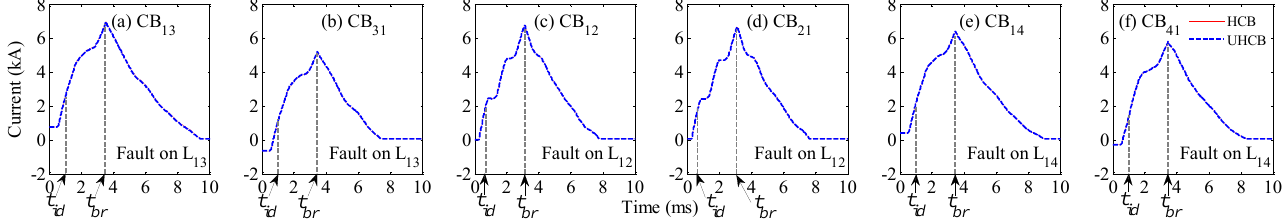
Fig. 6. Fault current for fault at middle of transmission line for BCBs and UCBs (a) fault on L 13 , CB 13 current, (b) fault on L 31 , CB 31 current, (c) fault on L 12 , CB 12 current, (d) fault on L 21 , CB 21 current, (e) fault on L 14 , CB 14 current, (e) fault on L 41 , CB 41 current